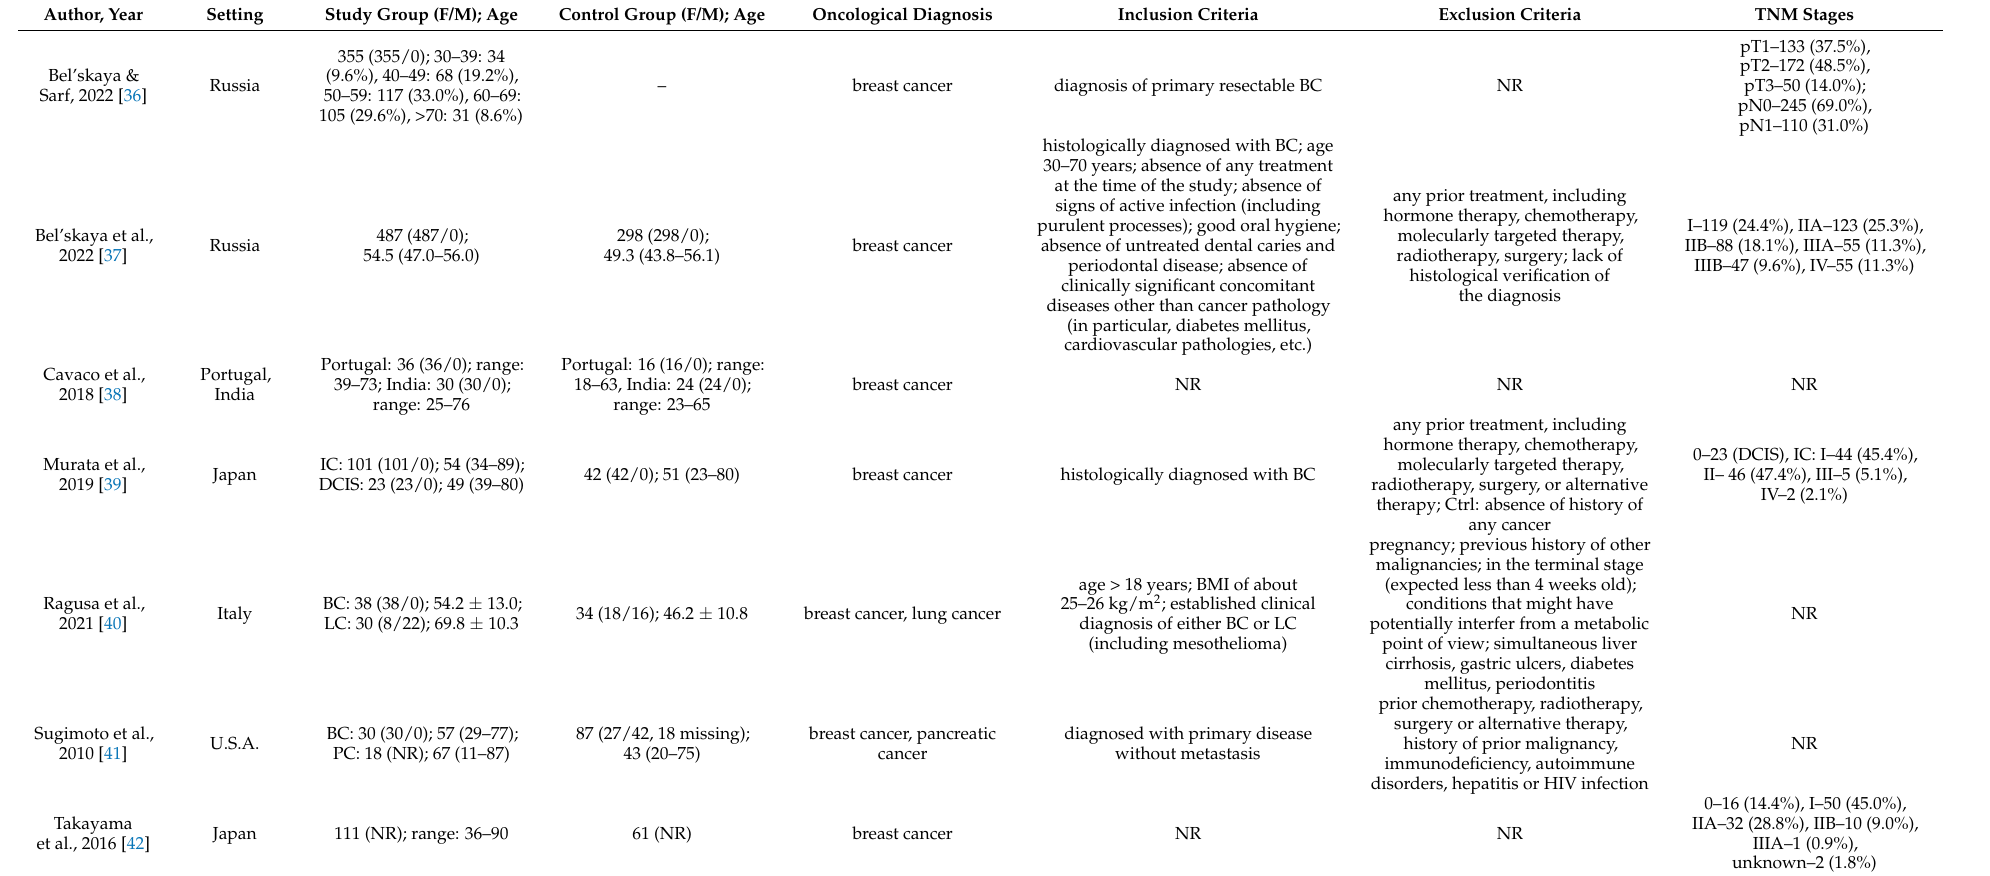
Table 2. General characteristics of included